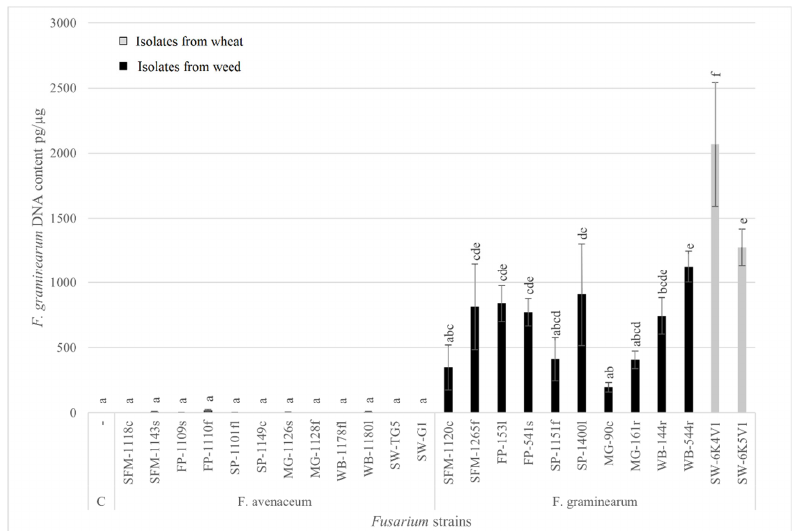
Figure 2. The DNA content of the pathogen F. graminearum ( F. graminearum DNA pg/plant DNA μ g) (±SEM) in spring wheat grains inoculated with different strains of F. avenaceum and F. graminearum from alternative host weeds and the main host wheat (values with different letters (a–f) indicate statistically significant differences ( p < 0.05) between study variants, C—water inoculated control). The lowest F. graminearum DNA content (194.8 pg/ µ g) was found in wheat inoculated with the MG-90c strain, which was isolated from meadow grass. In addition,